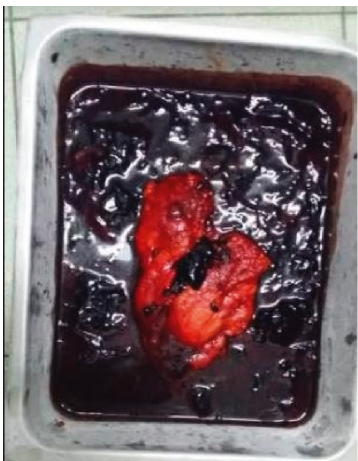
Figure 4: Postoperative left nephrectomy specimen with evacuated 3.5L blood and clots.